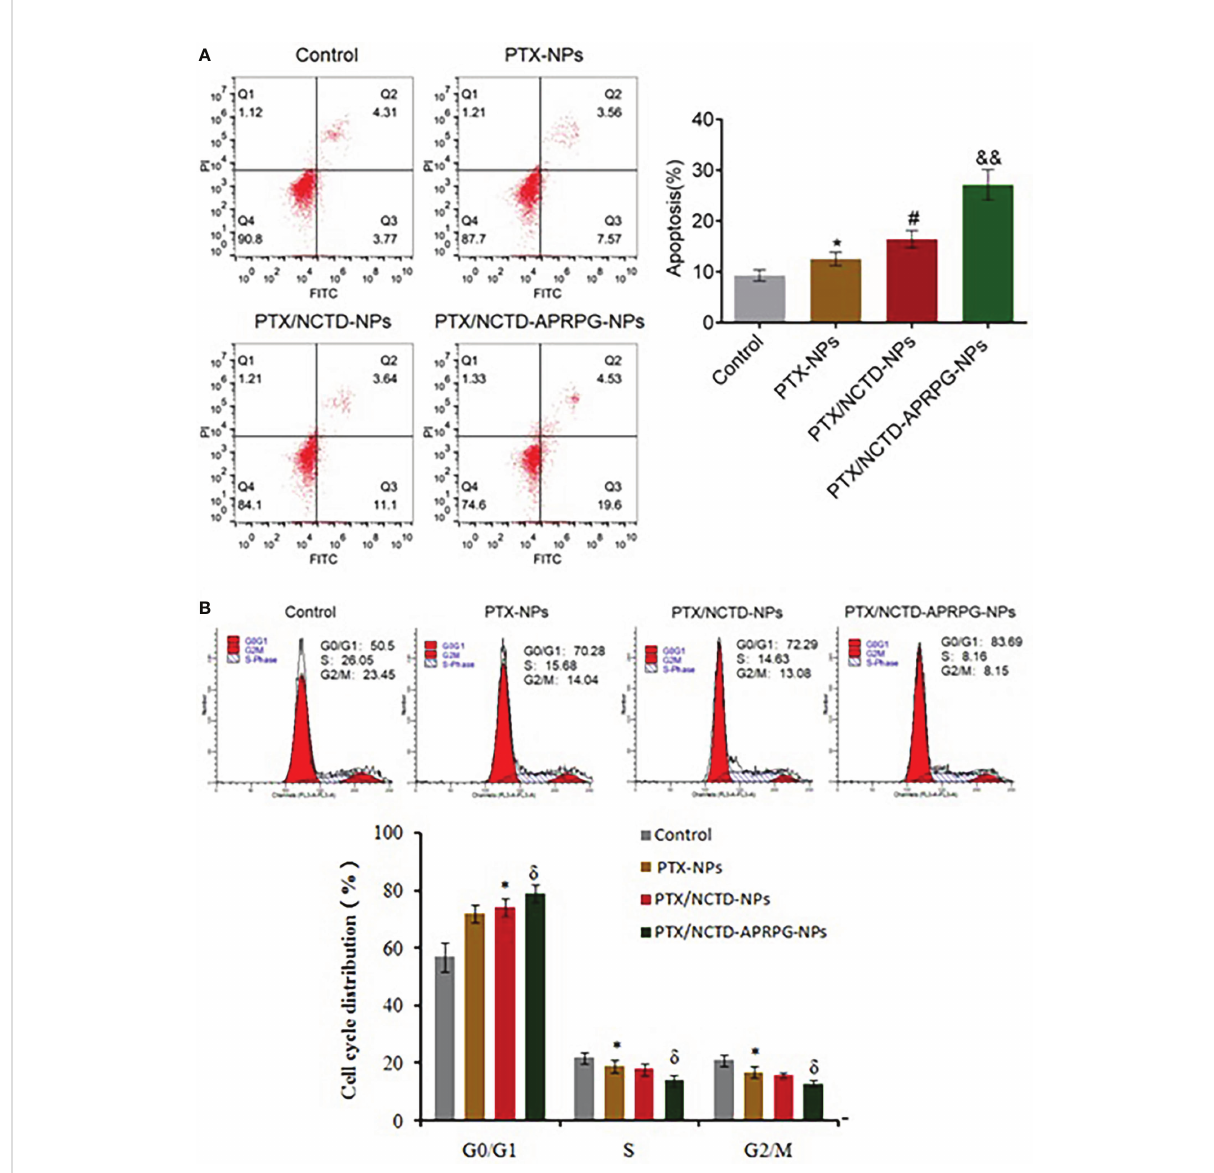
FIGURE 5 Apoptosis and cell cycle arrest were induced by PTX/NCTD-APRPG-NPs. Flow cytometry was conducted to determine the number of apoptotic cells and cell cycle distribution in HepG2 cells treated with PTX-NPs, PTX/NCTD-NPs, and PTX/NCTD-APRPG-NPs. (A) Effects of PTX-NPs, PTX/ NCTD-NPs, and PTX/NCTD-APRPG-NPs on apoptotic rates in HepG2 cells; (B) effects of PTX-NPs, PTX/NCTD-NPs, and PTX/NCTD-APRPG- NPs on the cell cycle distribution in HepG2 cells. * p < 0.05 vs. control, # p < 0.05 vs. PTX-NPs, & p < 0.05 vs. PTX/NCTD-NPs, && p < 0.01 vs.